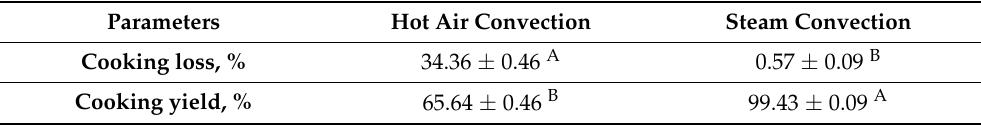
Table 1. Influence of hot air and steam convection on raw zucchini.